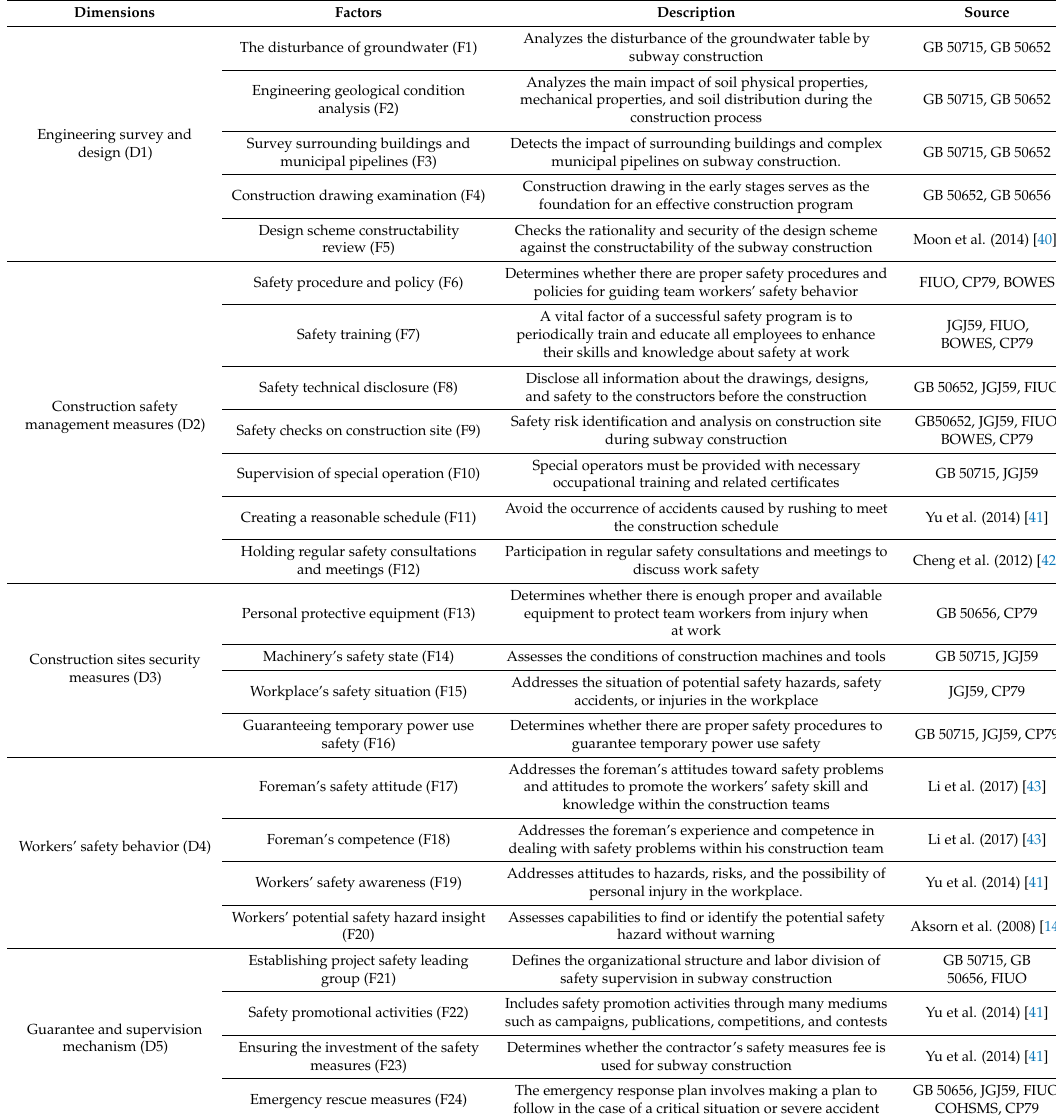
Table 2. The preliminary list of